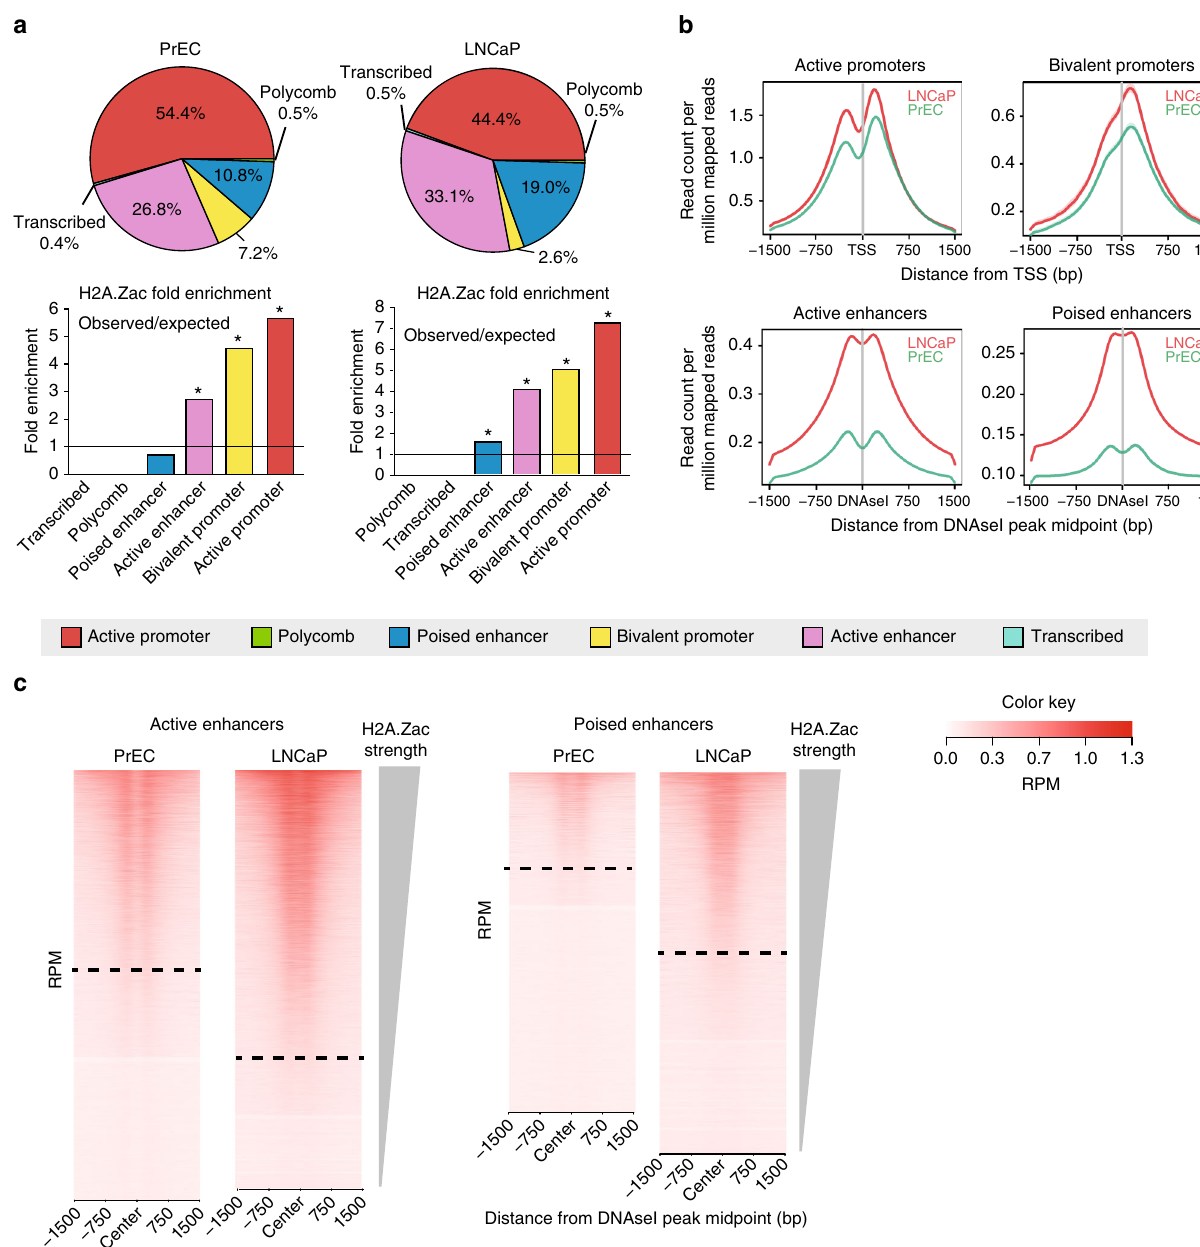
Fig. 2 H2A.Zac occupancy at genomic regions in PrEC and LNCaP. a Genomic Association Test (GAT) of H2A.Zac ChIP-seq and ChromHMM regions in LNCaP and PrEC cells. A total number of 42,538 H2A.Zac intersecting peaks from biological replicates were detected in LNCaP and 31,479 H2A.Zac peaks in PrEC. Pie charts (upper panel) representing the percentage of marked H2A.Zac peaks falling in each ChromHMM state. Observed vs. expected fold enrichment graphs (lower panel), * p- value < 0.0001 of signi fi cant enrichment. The line indicates the threshold of the signi fi cant enrichment. b Ngs plots of the average signal (read count per million mapped reads) of H2A.Zac ChIP seq in LNCaP (red) and PrEC (green) cells for each genomic region of signi fi cant enrichment. The plots were centered at the transcriptional start site (TSS) in the case of active and bivalent promoters and at the midpoints of DNase I hypersensitive sites sequencing (DNAseI) peaks in the case of active or poised enhancers. c Heatmaps showing H2A.Zac ChIP-seq signal (ordered by H2A.Zac signal intensity from top to bottom) across all the assigned active and poised enhancers, according to ChromHMM. H2A.Zac was centered using DNAseI midpoint. Dashed line separates enhancers as “ with H2A.Zac ” or “ without H2A.Zac ” . Scale bar shows the colorkey of the intensity of H2A.Zac ChIP average signal (read count per million mapped reads,